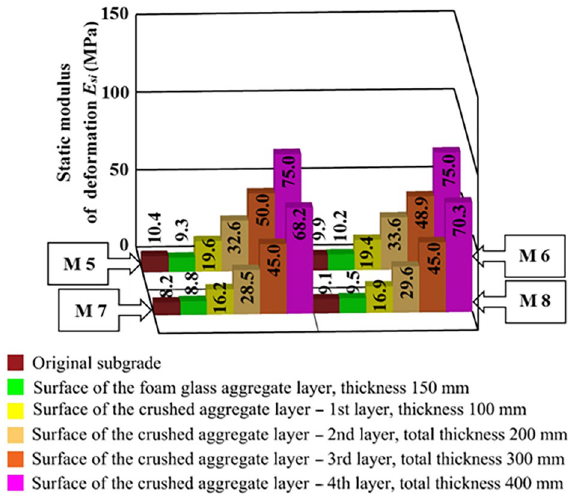
Figure 6. Values of the static modulus of deformation E si measured on the surface of the partial layers of the modified structural composition of the sub-ballast layers ( Segment B